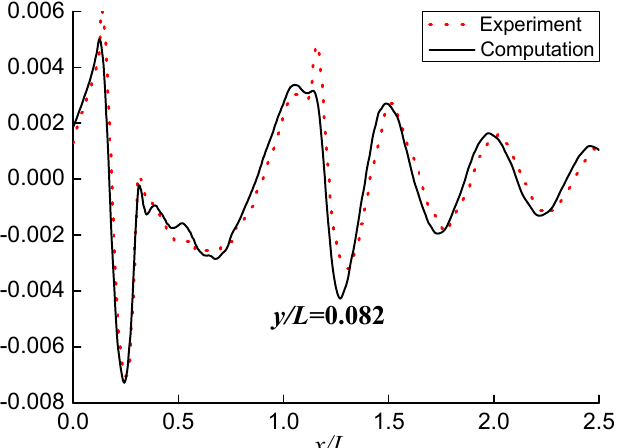
Figure 7. Comparison of wave elevation at y/L = 0.082 longitudinal section obtained by computation and experiment for intact ship.